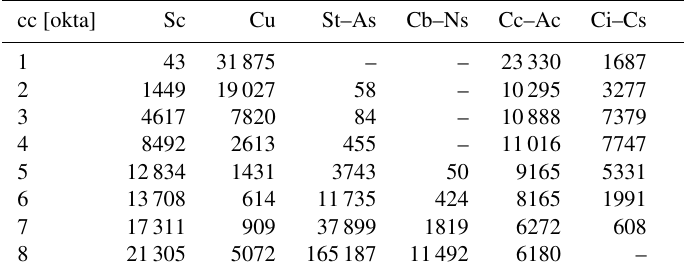
Table A1. Number of cases per okta for Davos and six cloud classes